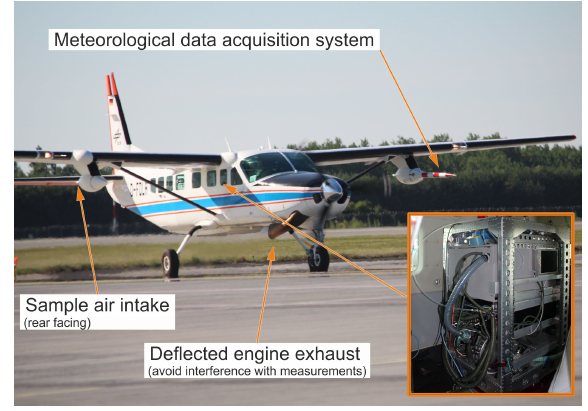
Figure 3. The DLR Cessna 208B on the taxiway at Katowice Air- port. The sample air intake is mounted underneath the right wing. The meteorological data acquisition system is underneath the left wing. The QCLS instrument (lower right panel) is located inside the cabin behind the pilot